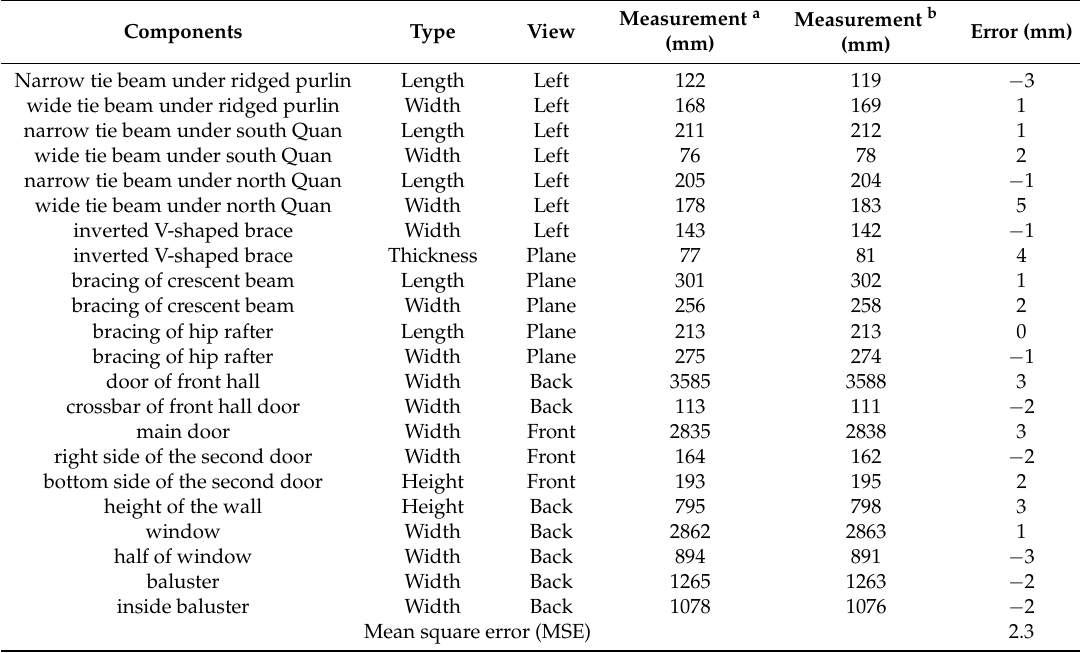
Table 2. Accuracy of fine surveying with the proposed approach.